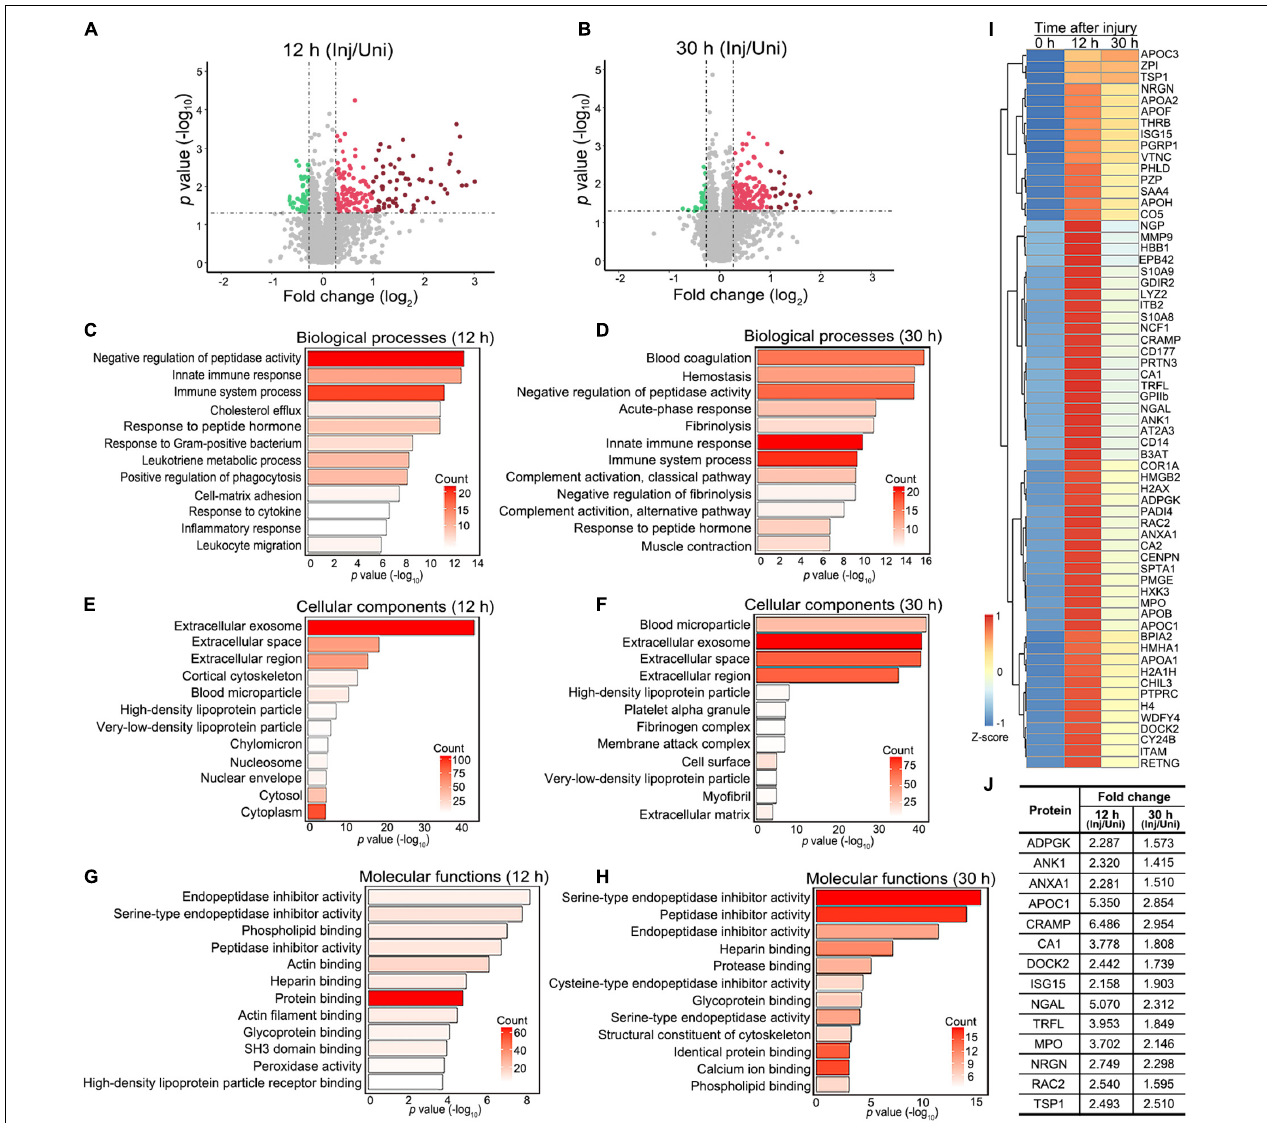
FIGURE 2 | Proteomic profiling and functional annotation of injured mouse sciatic nerve. (A,B) The volcano plots highlighting the proteins that are significantly and consistently changed at 12 h (A) or 30 h (B) after injury in the mouse sciatic nerve. Fold change (injured/uninjured) > 1.2 or < 0.83 and p -value < 0.05. Green dots, downregulated proteins. Red dots, upregulated proteins; dark red dots, highly upregulated proteins (fold change > 2 and p- value < 0.05). (C–H) Gene ontology (GO) term analyses of significantly changed proteins at 12 (C,E,F) and 30 h (D,F,H) regarding their involvement in biological processes (C,D) , cellular components (E,F) and molecular functions (G,H) . The top 12 terms ( p -value) and the counts of changed proteins in each term indicated by the color ramp are shown. (I) The heatmap showing the clustering of 63 proteins that are highly increased at 12 h or 30 h after injury (the dark red dots in A and B). Fold change (injured/uninjured) > 2 and p -value < 0.05. (J) The table showing 14 proteins from (I) that are associated with known or potential functions in the nervous system. The average fold changes of each protein (injured/uninjured) at 12 and 30 h after injury are shown. Inj, injured; Uni, uninjured.